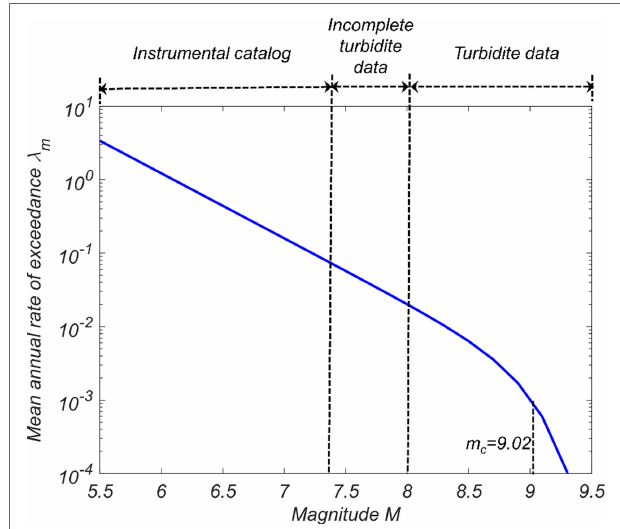
FIGURE 2 | Tapered Gutenberg–Richter relationship for Cascadia subduction zone.